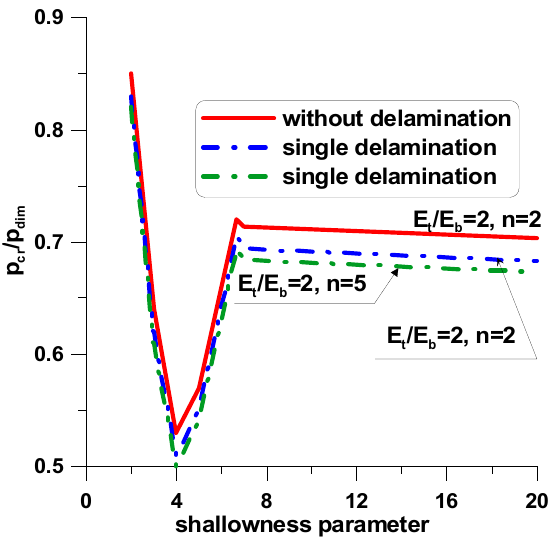
Figure 18. Distributions of buckling pressures for spherical shells made of FGMs with and without single delamination located at the shell mid-surface.